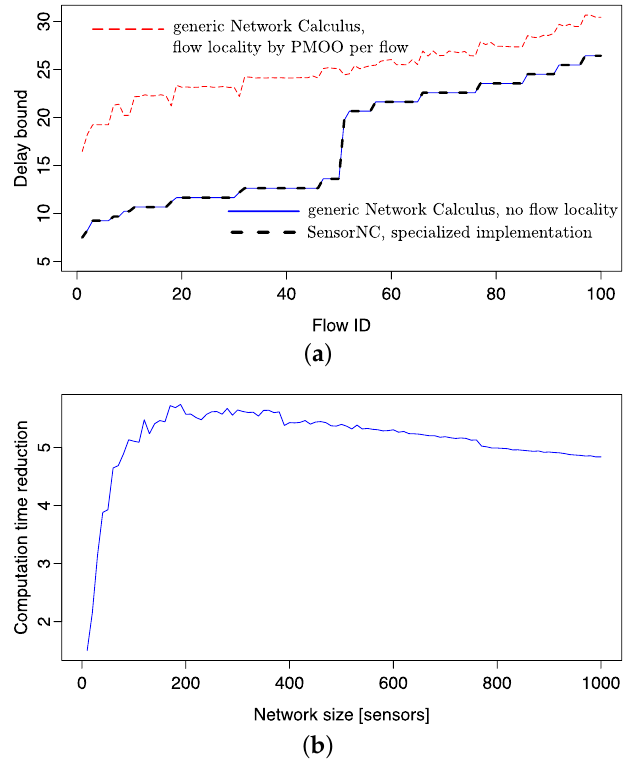
Figure 10. Generic network calculus computations vs. sensor network calculus (SensorNC): ( a ) delay bounds and ( b ) computation time